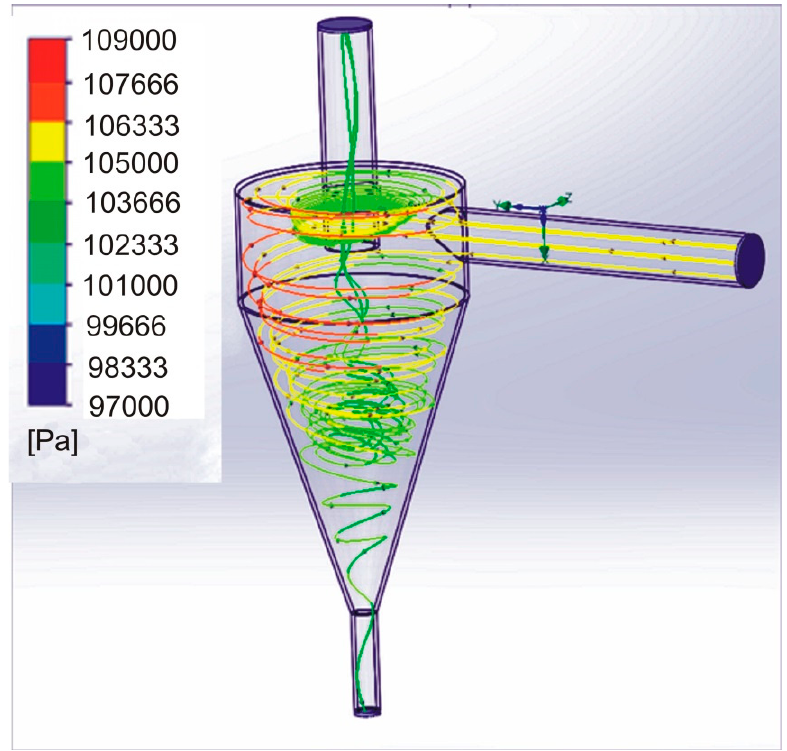
Figure 3. Isolines of pressure distribution in the hydrocyclone in the pressure-vacuum mode.